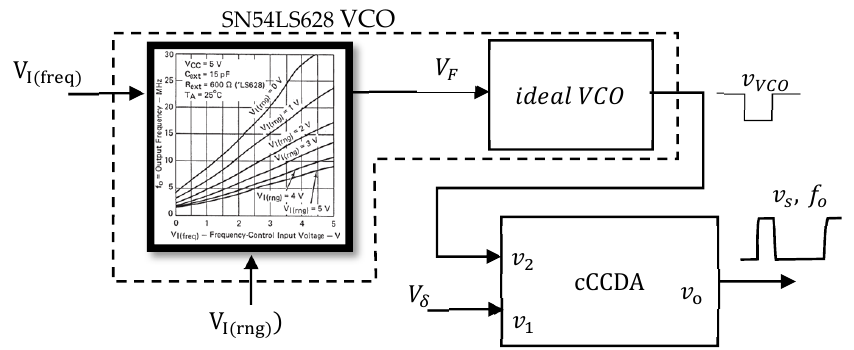
Figure 15. High-resistance cCCDA in series with a VCO.